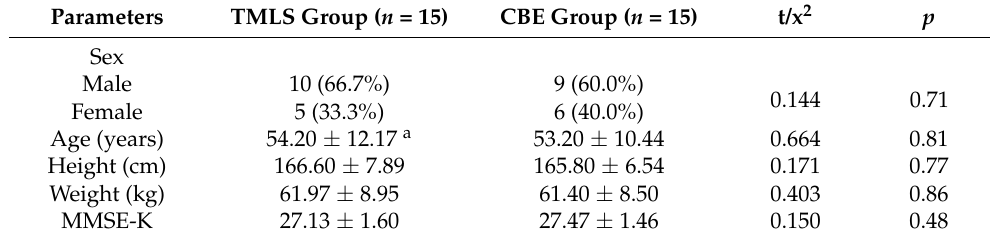
Table 1. General characteristics of the participants ( n = 30).